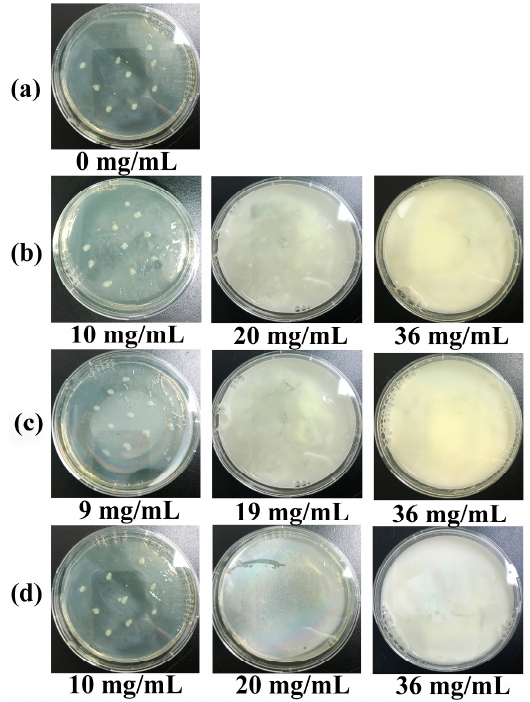
Figure 9. Antimicrobial tests of ( a ) blank control, ( b ) different concentrations of ZnO–SiO 2 -pH5.0 in agar medium, ( c ) different concentrations of ZnO–SiO 2 -pH7.0 in agar medium, ( d ) different concentrations of pure ZnO in agar medium. Table 3. MIC of ZnO–SiO 2 -pH5.0, ZnO–SiO 2 -pH7.0, and pure ZnO.